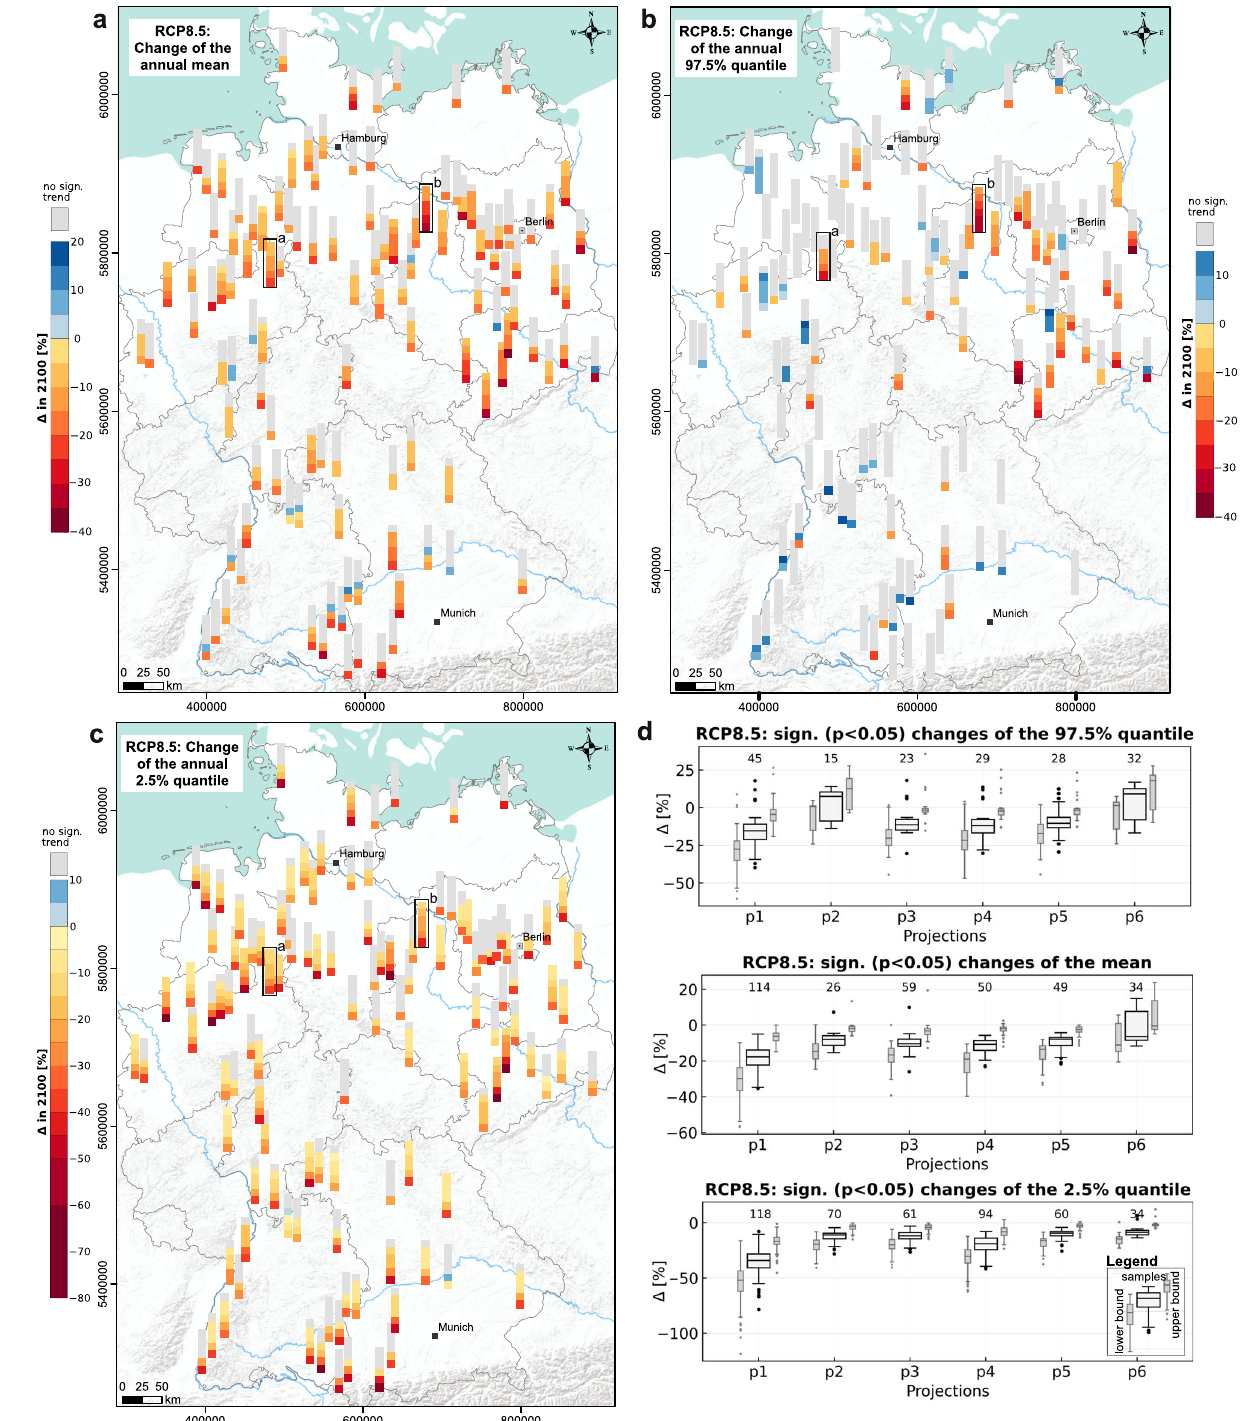
Fig. 1 Groundwater level changes (RCP8.5). Change of groundwater levels [%] in 2100 relative to 2014 (start of sim.) for each site and each climate projection, based on linear trend analysis: a mean, b 97.5% quantile, c 2.5% quantile; the order corresponds to the strength and sign of the change. d Boxplots showing the signi fi cant changes for a – c , light gray/sideways boxplots show the uncertainty of the change as 95% con fi dence interval. The numbers above boxplots depict the sample size (signi fi cant trends). Black boxes on maps depict the sites shown in Fig.